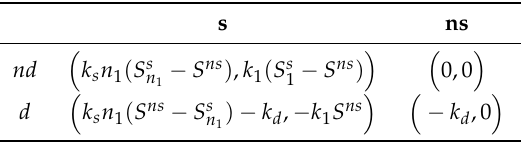
Table 2. Payoffs values for the game posed, when n 2 = 1. The payoff vectors are of the form u = ( u 1 , u 2 ) , where u 1 is the payoff of the server and u 2 is the payoff of the client. s